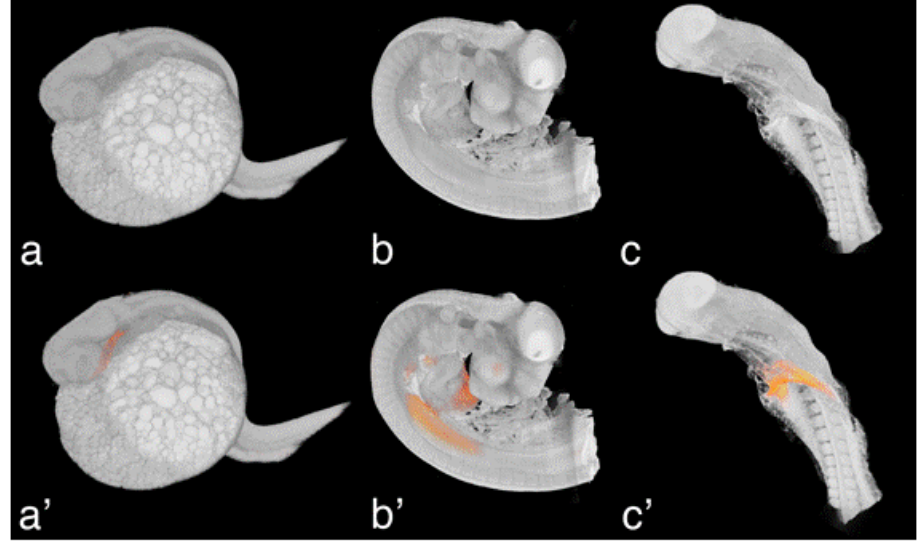
FIGURE 4. Volume-rendered 3D computer models. (a,a’) Zebrafish embryo (24–28 h). Note the mlc2 products indicating the heart tube in a’. (b,b’) Chick embryo (HH20). Note the tbx5 products in the left heart. (c,c’) Chick embryo (HH 10). Note the nkx2.5